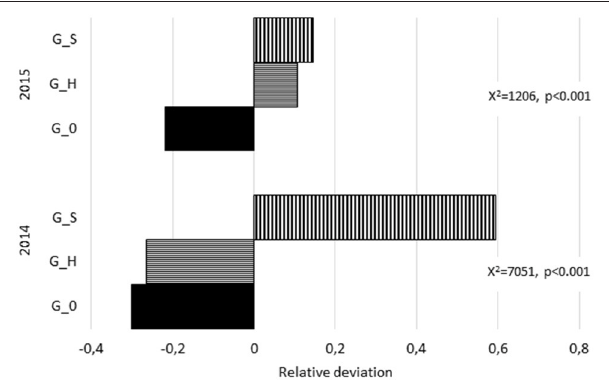
FIGURE 2 | Relative deviation of the GPS observations of ewes from hypothesized (i.e., random) GPS distribution in autumn (Period 4) after the summer grazing in 2014 and 2015, respectively, in each of the three summer grazing treatments [G_0 Control (no grazing), G_H Heifers grazing, and G_S ewes grazing with their offspring]. In Period 4, the ewes could graze the entire area freely. Relative deviation is calculated as the difference between the observed and hypothesized percentage (33%) divided by the hypothesized percentage. Positive deviation indicates preferred area by the sheep while negative deviation indicates avoided area. The distributions are compared by a X 2 Goodness-of-fit